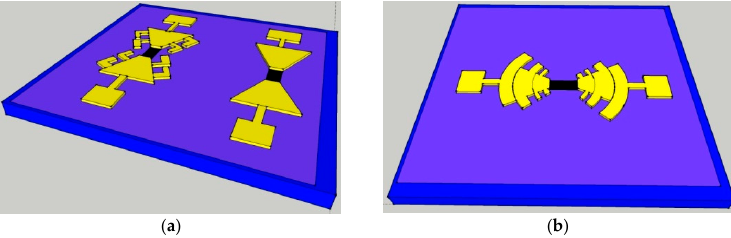
Figure 8. ( a ) The “beetle” (left) and bowtie (right) antennae and ( b ) the log-periodic, circular toothed antenna (not to scale). Both these were designed to have a resonating frequency at the required 1.2 THz. Here blue is Si, light purple is SiO 2 , yellow is the Ni-Al contact and black is the graphene.